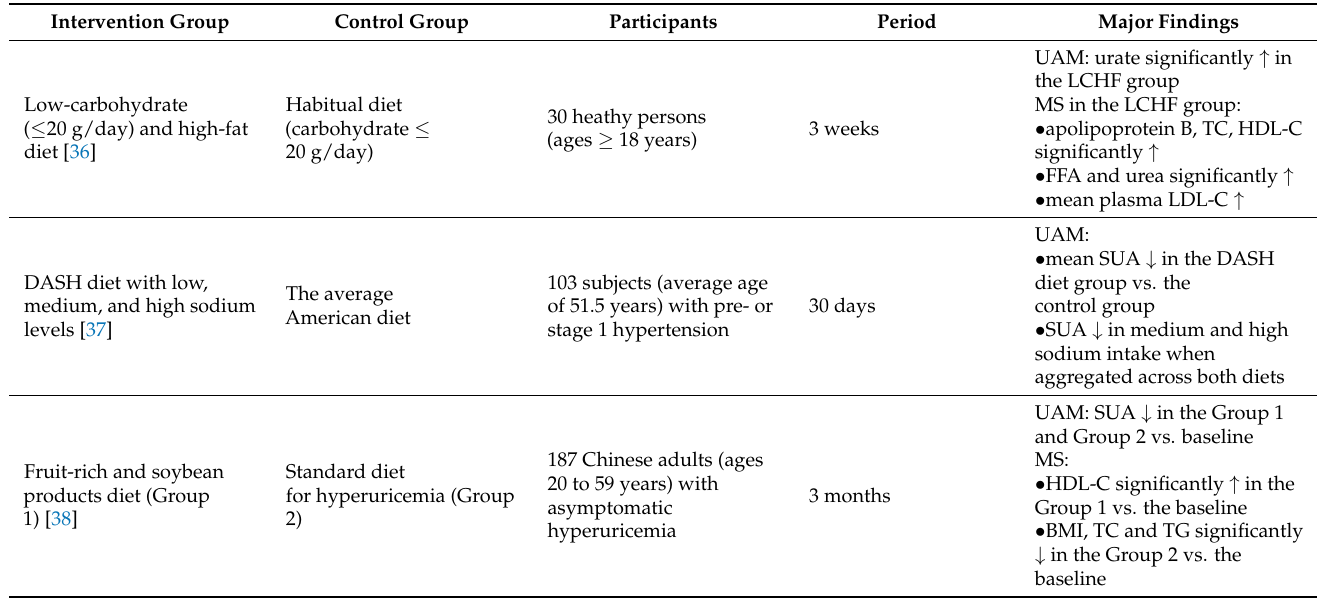
Table 1. Dietary intervention associated with the improvement of serum uric acid and indicators of metabolic